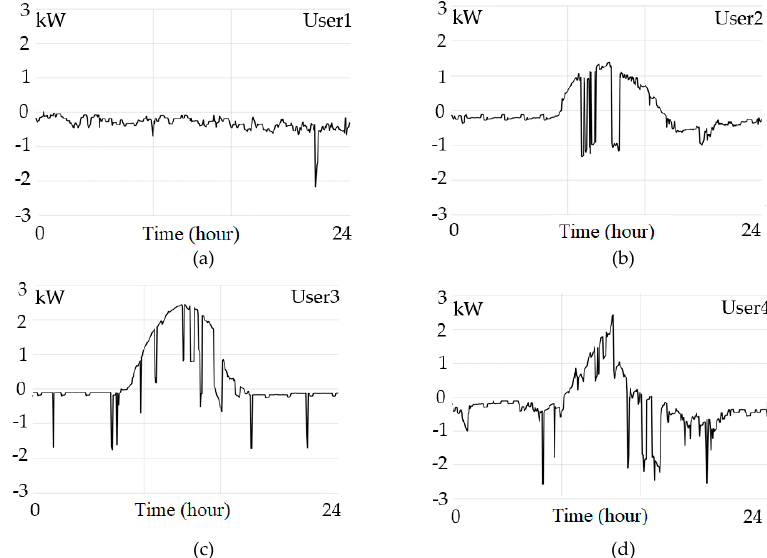
Figure 9. Case0: profiles captured by smart meters with time resolution equals 5s at meters of ( a ) User1, ( b ) User2, ( c ) User3 and ( d ) User4.